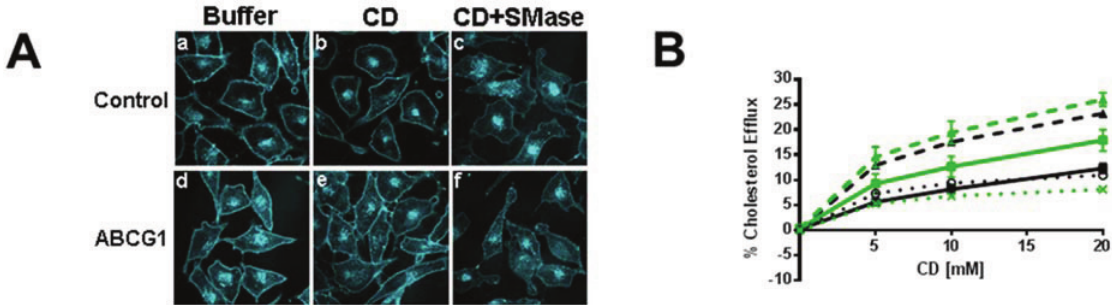
Figure 3. ABCG1-GFP expression increases efflux of SMase-mobilized cholesterol from the PM and LE. ( A ) Cold CD depletes excess PM FC from living ABCG1 cells. Control (a–c), and ABCG1 (d–f) cells pre-treated without (a,b,d,e), or, with SMase (c,f), were FC-depleted using 20 mM CD for 1h at 4 °C (b,c,e,f), then stained with filipin. ( B ) ABCG1 increases PM non-SM-associated-FC. Control ( black ) and ABCG1 ( green ) cells labeled with 3 H-FC were incubated in the absence or presence of SMase (solid and dashed lines, respectively) and, the percent of total cellular FC effluxed to CD for 1 h at 4 °C was determined. ( C ) Warm CD depletes excess ABCG1-induced PM and LE FC. ( C ) Control (a–c), and ABCG1 (d–f) cells pre-treated without (a,b,d,e), or, with SMase (c,f), were incubated with 5 mM CD for 10 min at 37 °C. ( D ) ABCG1 increases non-SM-associated cellular FC. Control ( black ) and ABCG1 ( green ) cells labeled with 3 H-FC were incubated in the absence or presence of SMase (solid and dashed lines, respectively) and, the percent of total cellular FC effluxed to CD for 10 min at 37 °C was determined. ( E ) ABCG1 enhances efflux of SMase-mobilized FC to liposomes and ( F ) HDL. Control ( black ) and ABCG1 ( green ) cells labeled with 3 H-FC were incubated in the absence or presence of SMase (solid and dashed lines, respectively) for 4 h and, the percent of total cellular FC effluxed to liposomes or HDL was determined. For ( B , D ) PM SM-associated FC is represented by the difference curves (percent FC efflux of (SMase-treated cells)—(non-treated cells)); black and green dotted lines, control and ABCG1 cells, respectively). All values are expressed as mean + S.D. Data shown is representative of at least three replicate experiments Two-way ANOVA analyses using multiple comparisons revealed that ABCG1 expression and SMase treatment significantly increased the percent CD-mediated cholesterol efflux in ( B ) and ( D ) p < 0.0001. However, the values for the percent cellular efflux for SMase-treated control and SMase-treated ABCG1 cells (dashed lines) using 15 mM and 10 mM CD were not significantly different in ( B ) ( p = 0.1592 and p = 0.0841, respectively), or in ( D ) ( p = 0.2904 and p = 0.4282, respectively). In addition the value for the percent Cholesterol Efflux was not significantly different for SMase-treated ABCG1 cells vs . non-treated ABCG1 cells using 20 mM CD ( p = 0.9988). All values in ( E ) were significantly different ( p < 0.0001) with the exception of ABCG1 cells vs . SMase-treated ABCG1